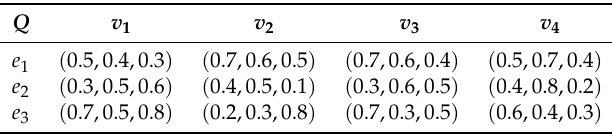
Table 7. Neutrosophic soft relation Q